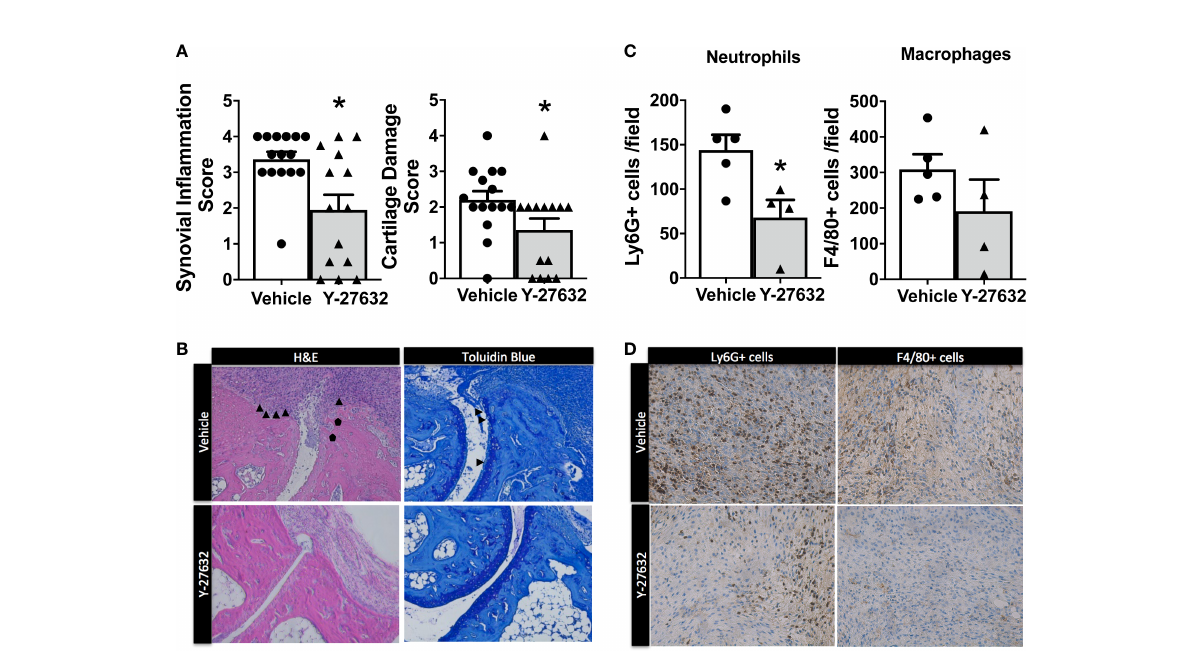
FIGURE 2 Decreased synovial in fl ammation and cartilage damage in arthritic mice treated with Y-27632 . (A) Comparison of the histologic scores of synovial in fl ammation and cartilage damage in ankle and forefoot joints of arthritic mice treated with either Y-27632 (n = 14) or vehicle (n = 15). (B) Representative histologic images of the joints stained with hematoxylin and eosin (H&E) and toluidine blue. ▲ indicates synovitis and invading pannus and ● indicates subchondral bone erosion in the H&E sections and ▲ indicates proteoglycan loss (destaining of super fi cial cartilage) and erosion of super fi cial cartilage in the Toluidin blue stained sections. Values are the Mean ± Standard error of the mean (SEM). *p < 0.05 (Mann-Whitney test). (C) Number of cell Ly6G+ neutrophils or F4/80 macrophages in the in fl ammatory in fi ltrate of joints from arthritic mice treated with Y-27632 (n = 5) or vehicle (n = 4), with a clinical score of 2-3. (D) Representative images of the joint in fi ltrate stained with the anti-Ly6G+ or anti-F4/80 antibodies. Values are the Mean ± Standard error of the mean (SEM). *p < 0.05 (Mann-Whitney